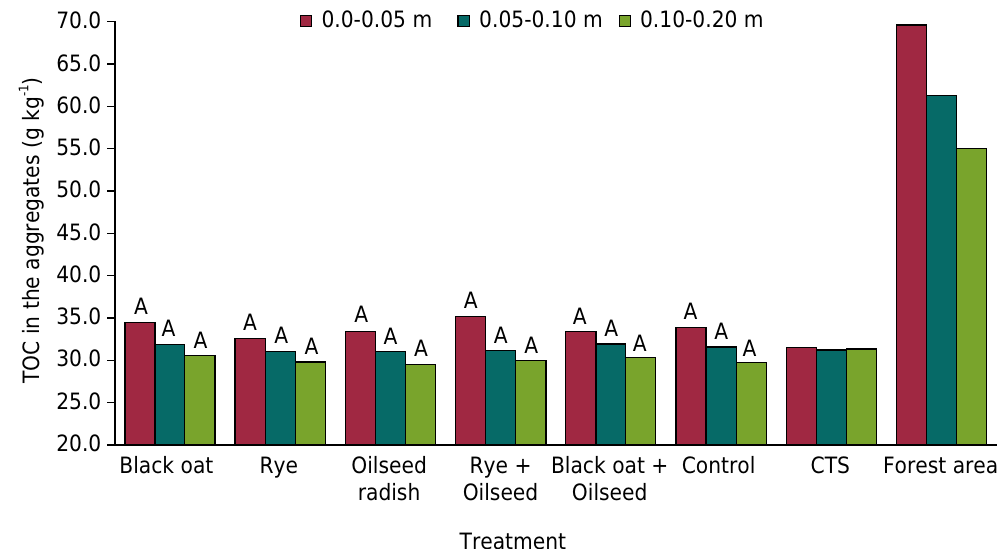
Figure 1. Total organic carbon (TOC) content in the macroaggregates of a Humic Dystrudept cultivated with onion under no-till compared to conventional tillage and forest area. Different letters, at each depth, indicate statistical differences by the Scott-Knott test at 5 %. CI (m ± 95 %) = 0.38, 0.48, and 0.19 for 0.00-0.05, 0.05-0.10, and 0.10-0.20 m, respectively, in the CTS. CI (m ± 95 %) = 2.42, 1.71, and 1.86 for 0.00-0.05, 0.05-0.10, and 0.10-0.20 m, respectively, in the forest